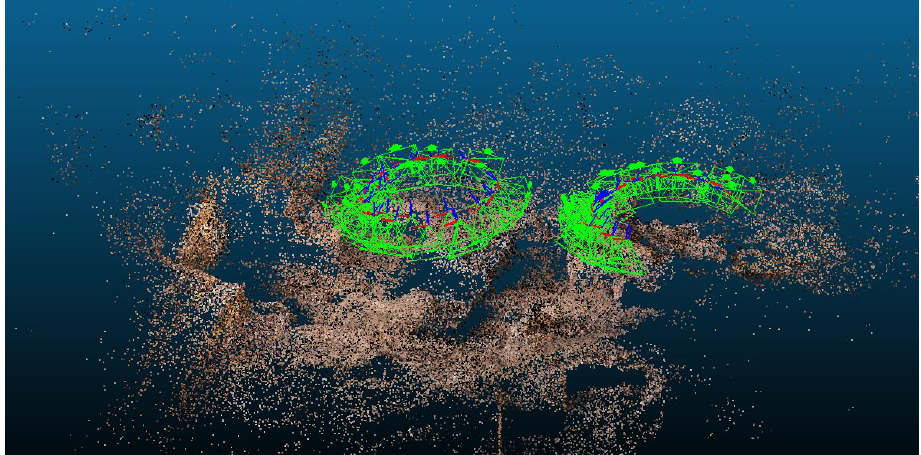
Figure 9. Part of the sparse model of the archaeological site of “Cueva Pintada” generated in GRAPHOS, showing each camera position during data acquisition in green.